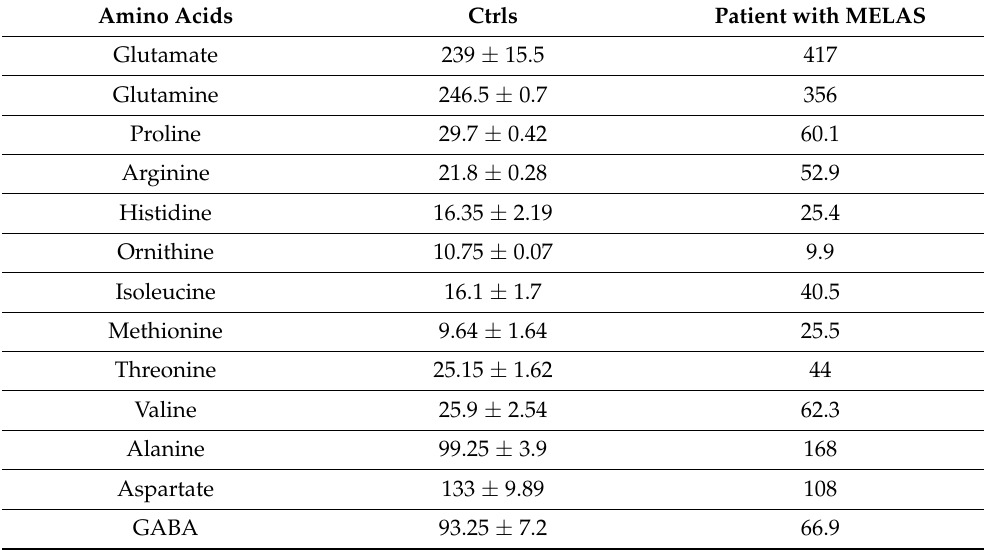
Table 2. Mass spectrometry quantification of amino acids in post-mortem brain tissue from Ctrls and a patient with MELAS.